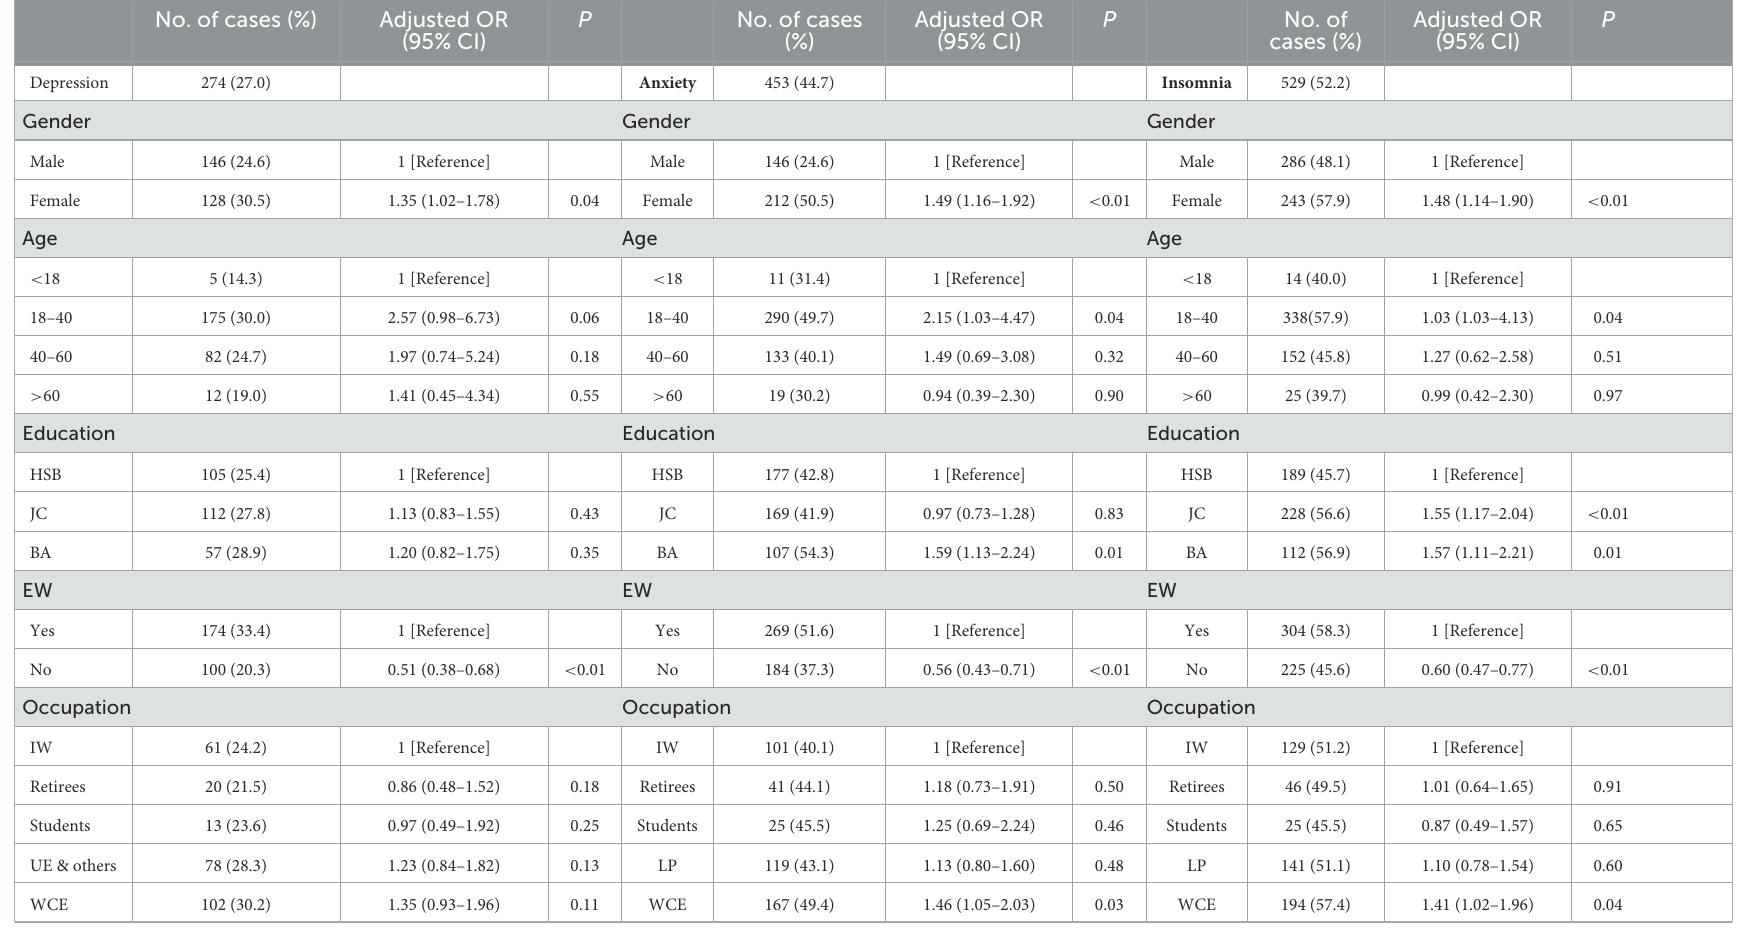
TABLE 3 Prevalence of depression, anxiety and insomnia according to the demographic